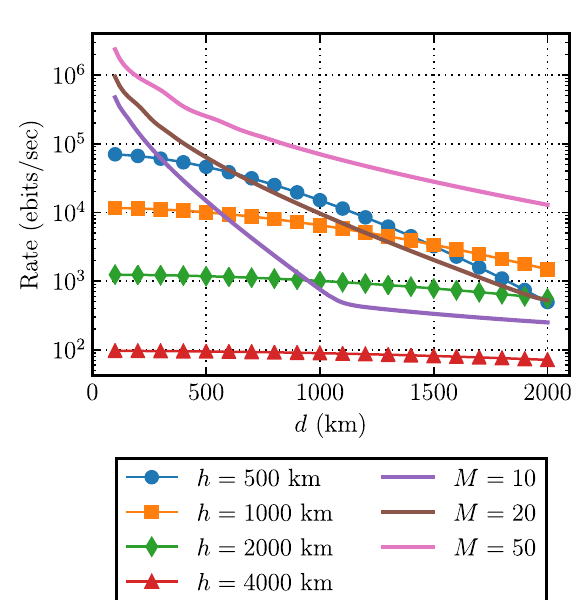
Fig. 7 Comparison of satellite-based entanglement distribution to ground-based repeater-assisted entanglement distribution. We consider two ground stations at the equator separated by a distance d , with N R = 20 satellite rings and N S = 20 satellites per ring. We compare to a ground-based repeater chain of the same distance d consisting of M elementary links of equal length and N mem = 50 quantum memories per elementary link. The rate is given by eq.